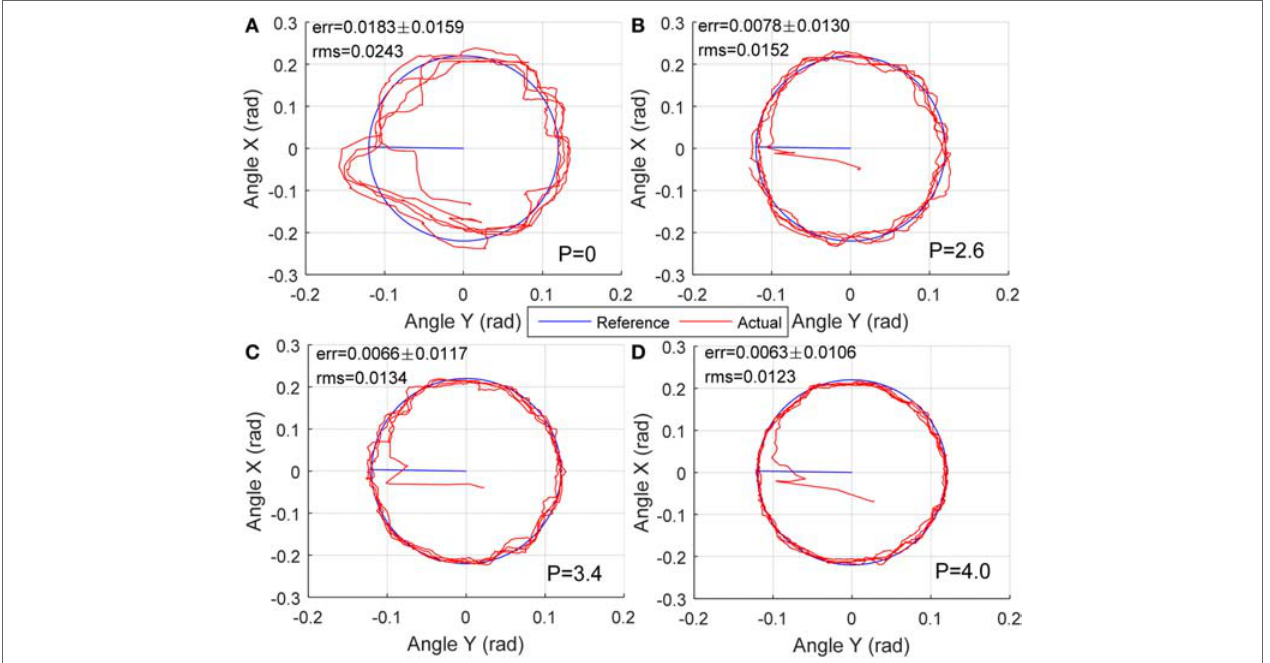
FIGURE 9 | Human–robot passive movement training with varying compliance dominated by nominal different pressures: (A) P = 0, (B) P = 2.6 bar, (C) P = 3.4 bar, and (D) P = 4.0 bar.